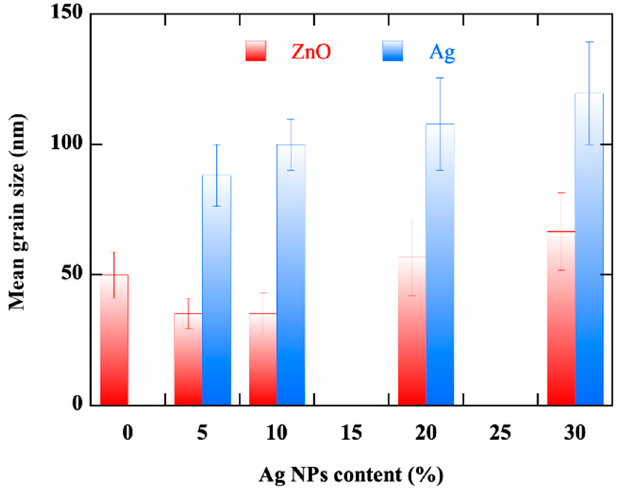
Figure 6. Average size of ZnO grains and Ag NPs as a function of Ag NPs content in the nanocom- posite deduced from SEM images.